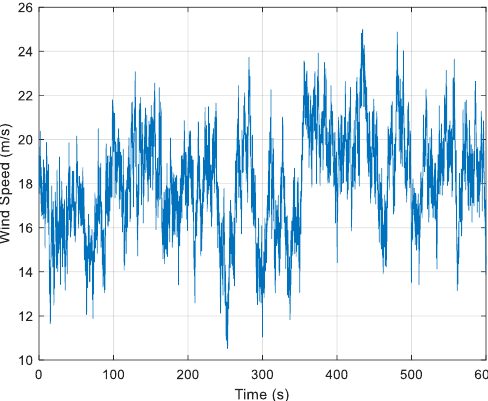
Figure 10. Random 17 m/s mean wind speed. Table 2. Test simulation cases.